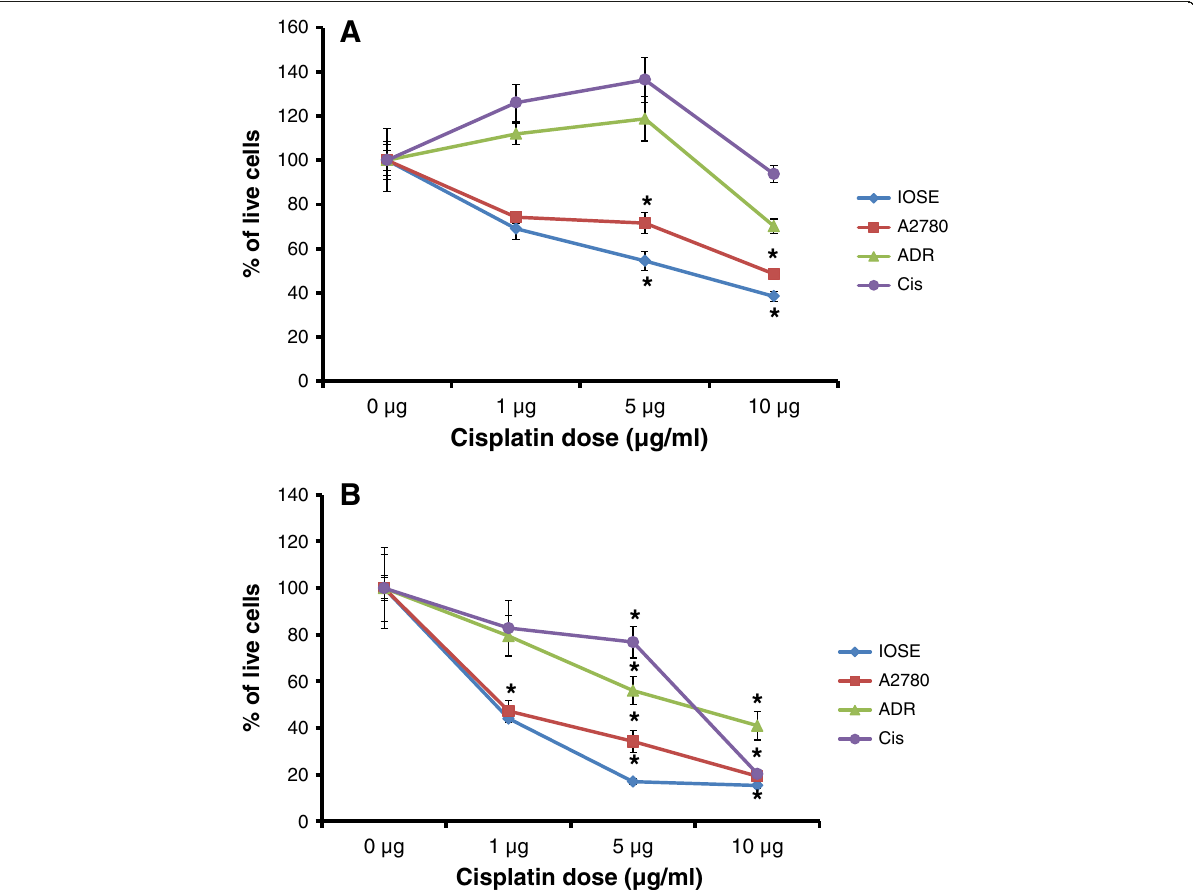
Figure 2 Graphical representation of cell viability following various doses of Cisplatin treatment with time. ( A ) Percentage of live cells after 24 hours treatment with 3 doses of Cisplatin (1, 5 and 10 μ g). ( B ) Percentage of viable cells following 48 hours of Cisplatin treatment. Values represent means for each group ± SEM (* p < 0.001 one way ANOVA and